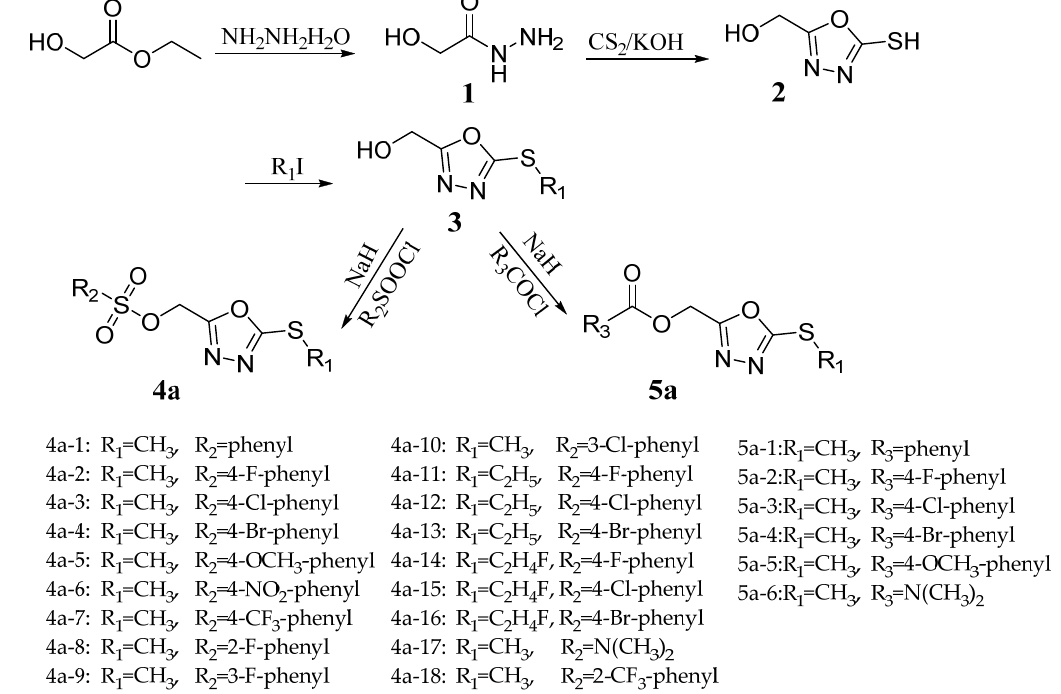
Table 1. Inhibition rate (%) of target compounds against Xanthomonas oryzae pv. oryzae and Xanthomonas axonopodis pv. citri